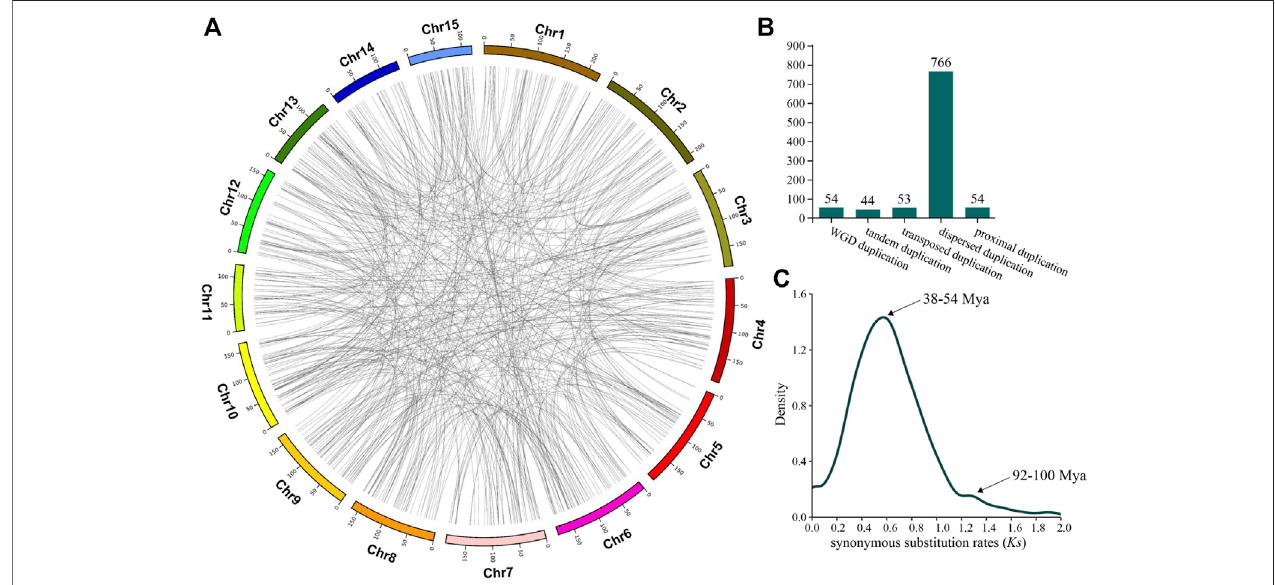
FIGURE 2 | Camellia -speci fi c genes (CSGs) originating from gene duplication. (A) Distribution of CSGs on chromosomes by fi ve mechanisms of origin. (B) The CSGs number of different duplication types. (C) Density distribution of synonymous substitution rates ( Ks ) values between CSGs and paralogous genes.